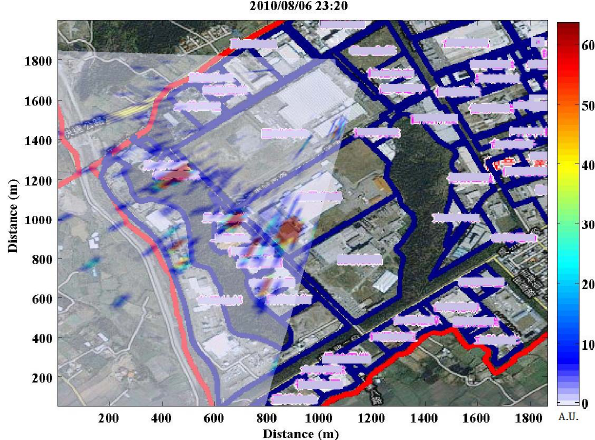
Figure 11. Lidar sector scan at 532nm over the Guanyin industrial area on 6 August 2010. The topographical map (Google Maps) have been